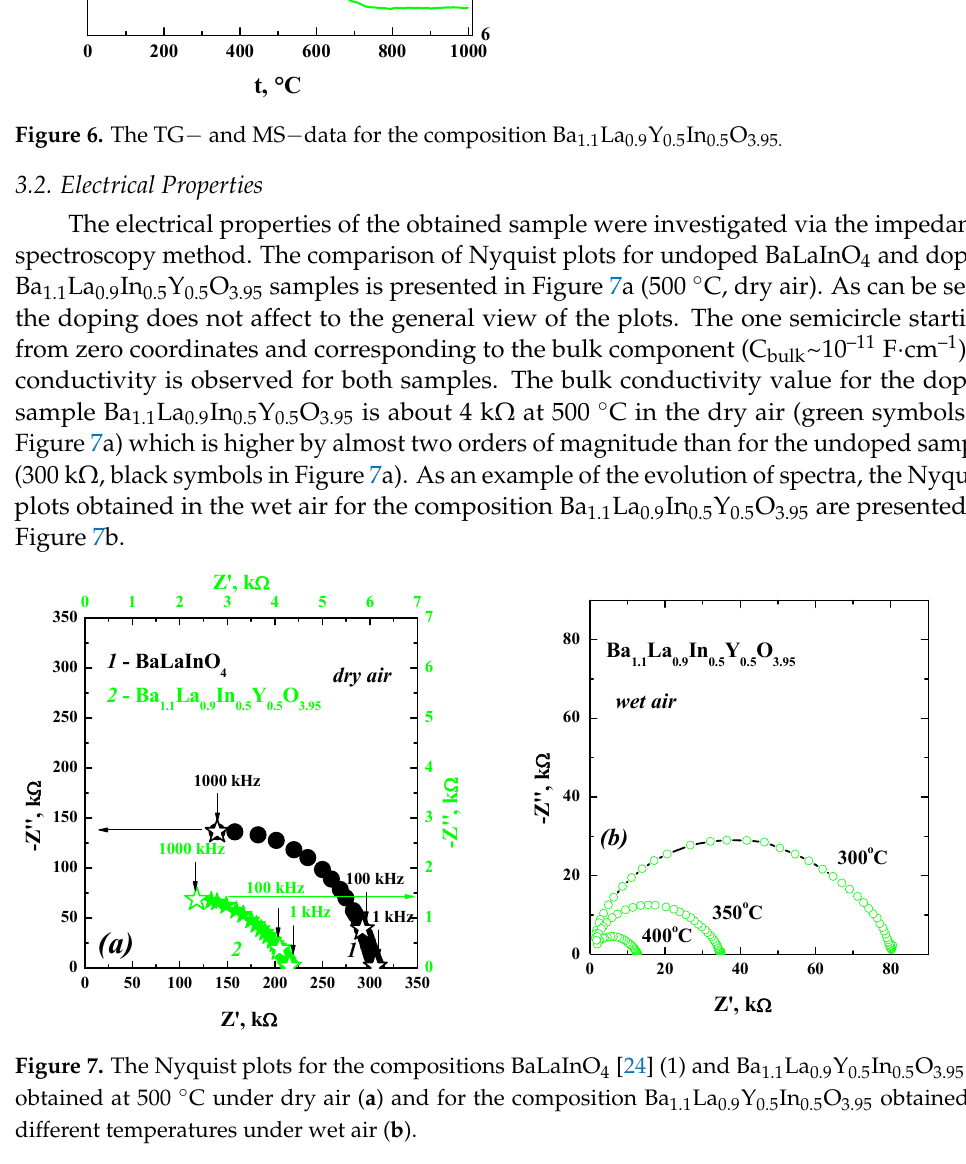
Figure 7. The Nyquist plots for the compositions BaLaInO 4 [24] (1) and Ba 1.1 La 0.9 Y 0.5 In 0.5 O 3.95 (2) ob- tained at 500 °C under dry air ( a ) and for the composition Ba 1.1 La 0.9 Y 0.5 In 0.5 O 3.95 obtained at different temperatures under wet air ( b ).